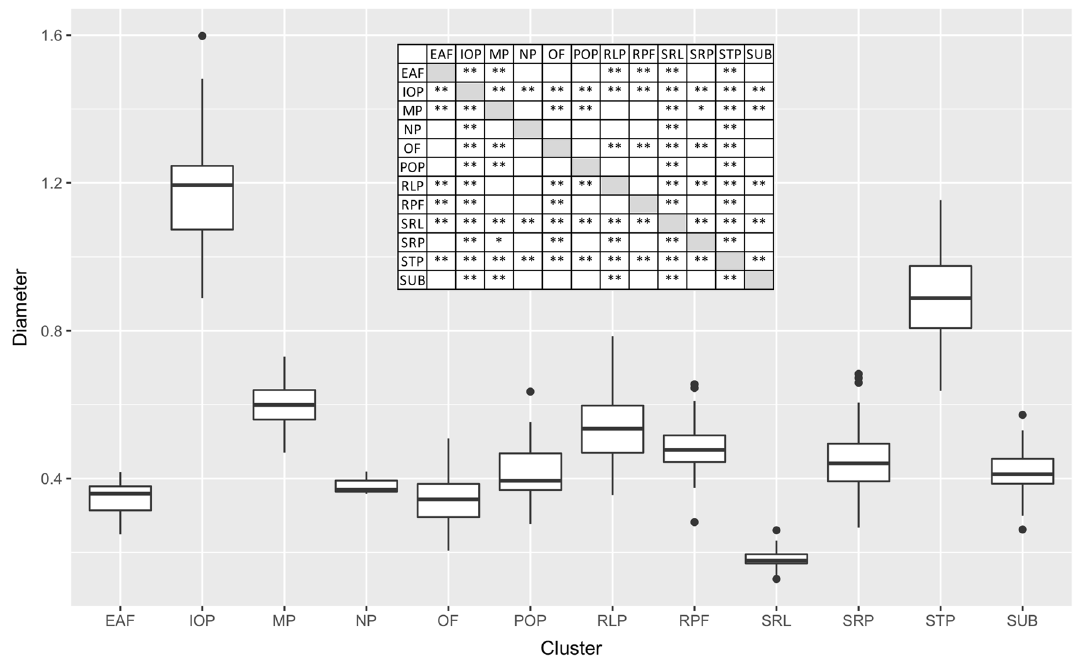
Figure 4. Box-plot of the measured pore size for each cluster. The diameter is in mm. In the table the results from the Tukey test **: p value < 0.05; * p -value < 0.1. Three clusters have an average pore size statistically different from all other cluster (IOP, SRL, and STP). EAF: ethmoid cluster; IOP: infraorbital cluster; MP: mandibular cluster; NP: nasal cluster; OF: oral cluster; POP: preorbital cluster; RLP: rostrolateral cluster; RPF: rostral cluster; SRL: supra-rostrolateral cluster; SRP: suprarostral cluster; STP: supratemporal cluster; SUB: subrostral